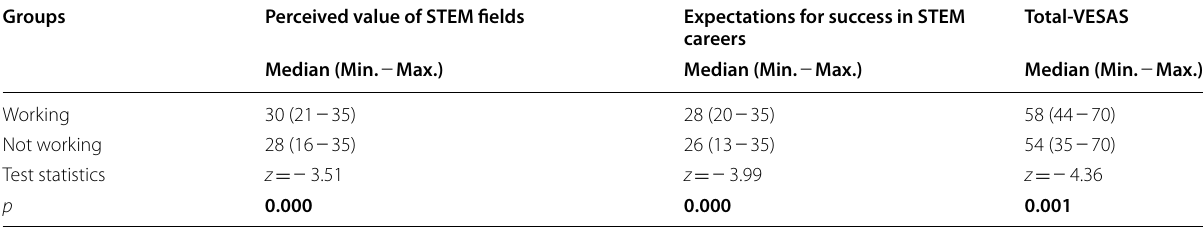
Table 9 The results of Mann Whitney U test for participants’ STEM motivation scores according to the variable of ‘having a role model working in a STEM field’